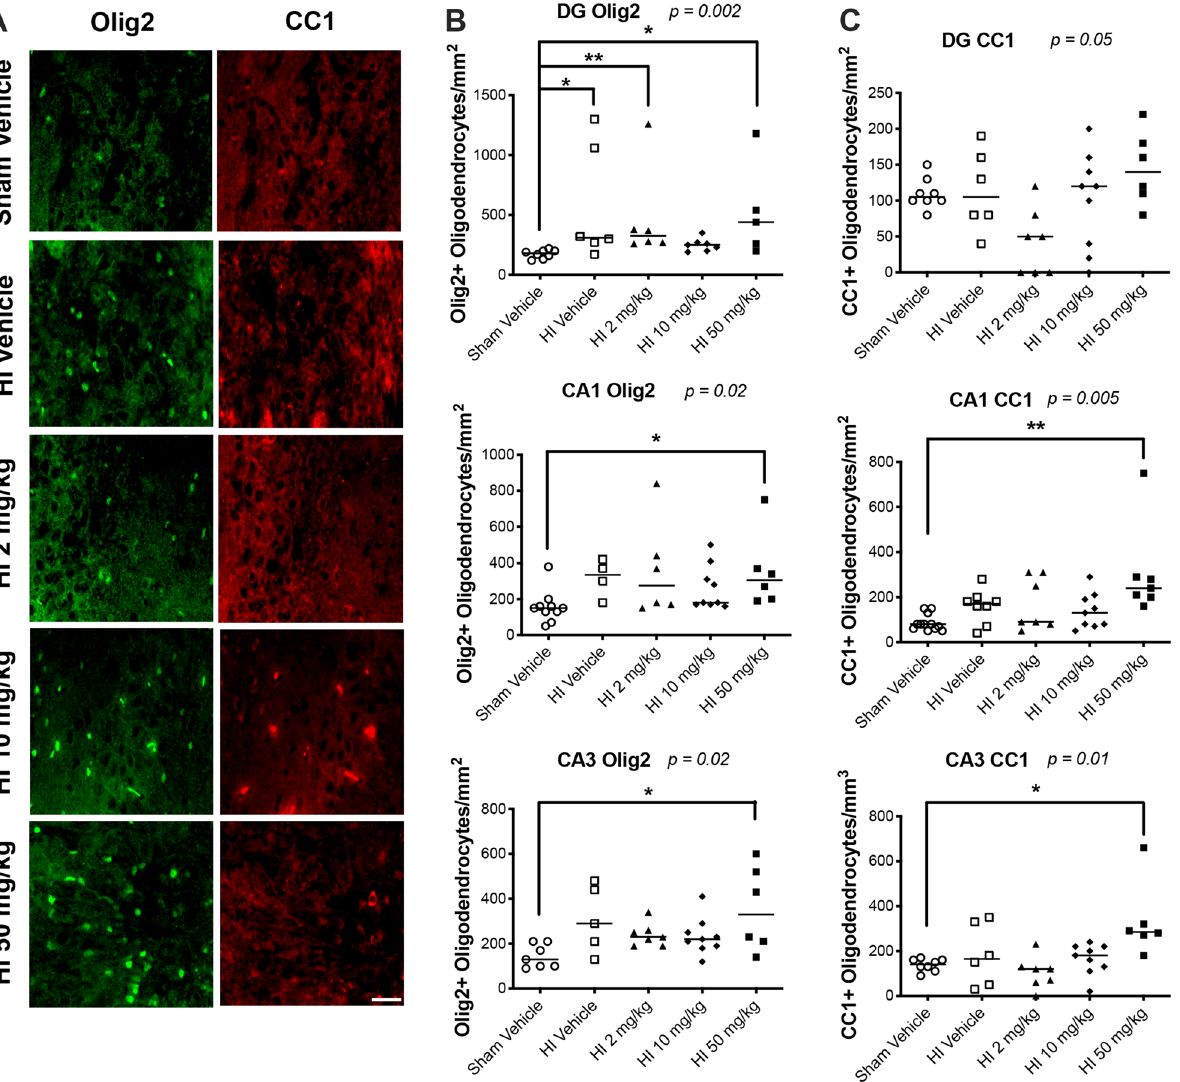
Figure 4. Immunostaining for oligodendrocytes in sham and HI rat pups treated with vehicle or sildenafil. Cells were counted in three regions of the hippocampus: i.e., dentate gyrus, CA1, and CA3 regions of the ipsilateral hippocampus. ( A ) Representative immunofluorescent micrographs of the immature oligodendrocytes labeled with Olig2 and mature oligodendrocytes labeled with CC1 in the ipsilateral CA3 region of the hippocampus. ( B ) Immature oligodendrocytes labeled with Olig2, and ( C ) mature oligodendrocytes labeled with CC1 (median with individual data points representation). Significance: p value from Kruskal–Wallis test, with Dunn’s post-hoc comparison tests: * p < 0.05, ** p < 0.01. Number of animals: n = 8 sham vehicle, 6 HI vehicle, 7 HI 2 mg/kg, 9 HI 10 mg/kg and 8 HI 50